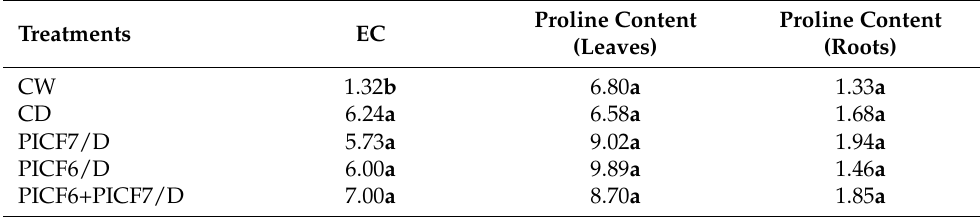
Units of EC are expressed in dS/m. Proline content (leaves and roots) is expressed in µ mol proline/g of fresh weight material. CW, control plants just irrigated with distilled water; CS, plants treated with salt (S) solution; PICF7/S, plants inoculated with Pseudomonas simiae PICF7 and treated with S solution; PICF6/S, plants inoculated with Pseudomonas sp. PICF6 and treated with S solution; PICF6+PICF7/S plants co-inoculated with strains PICF6 and PICF7 and treated with S solution. Data are means on three plants. Within each column, different letters indicate significant ( p < 0.05) differences among treatments according to Tukey (HDS) test. EC and proline measurements were performed for the two experiments obtaining similar